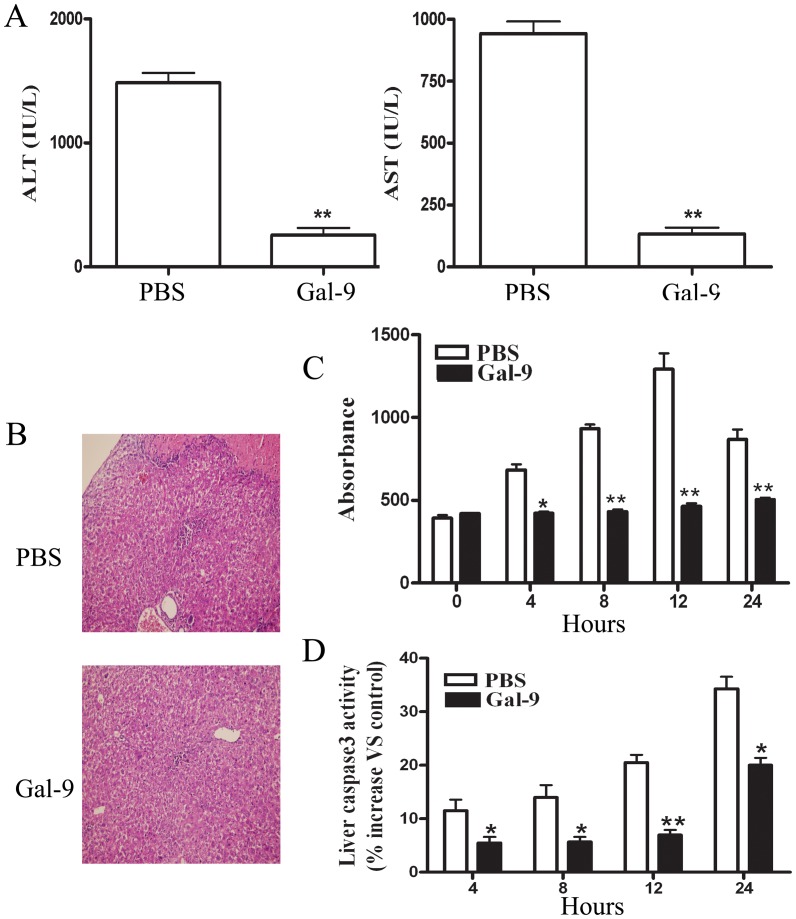
Effect of galectin-9 treatment on Con A-induced hepatitis.Galectin-9 (100 µg per mouse) or PBS was administrated i.v. to Balb/c mice (n = 8 per group) 30 min before Con A injection (20 mg kg–1). (A) Serum ALT and AST levels were measured 24 h after Con A injection. (B) The livers were removed 24 h later. Paraffin sections were stained with hematoxylin and eosin (H&E). Representative liver sections were shown for each group, original magnificatios: ×200. (C) Liver DNA fragmentation was monitored by assessing histone ELISA, with or without pretreatment with galectin-9. (D) Time course of liver caspase 3–like activity are shown. The results (A, C, D) were presented as the mean ± SD of three separate experiments. **, p<0.01; *, p<0.05 vs PBS treatment; PBS, PBS treatment in Con A-treated mice; Gal-9, galectin-9 pretreatment in Con A-treated mice. Similar data presentation will appear in the subsequent figures.